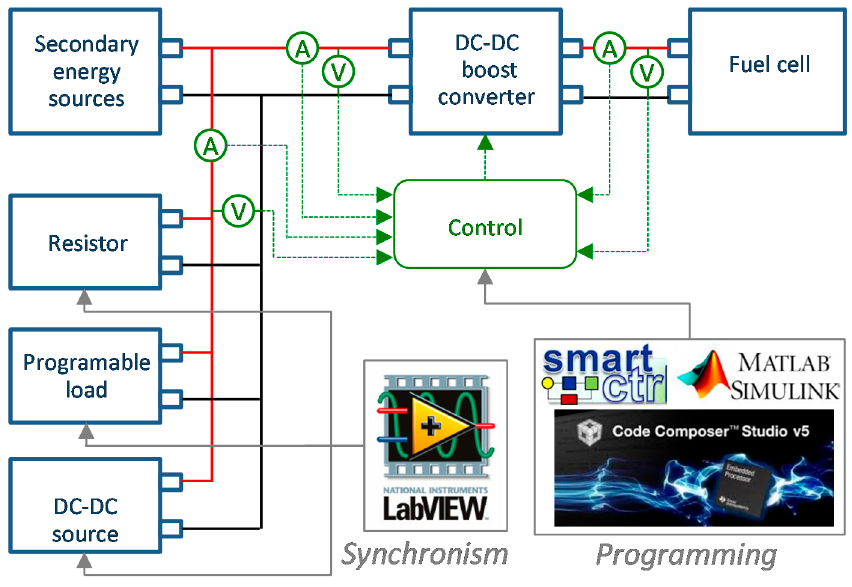
Figure 29. Connection block diagram.